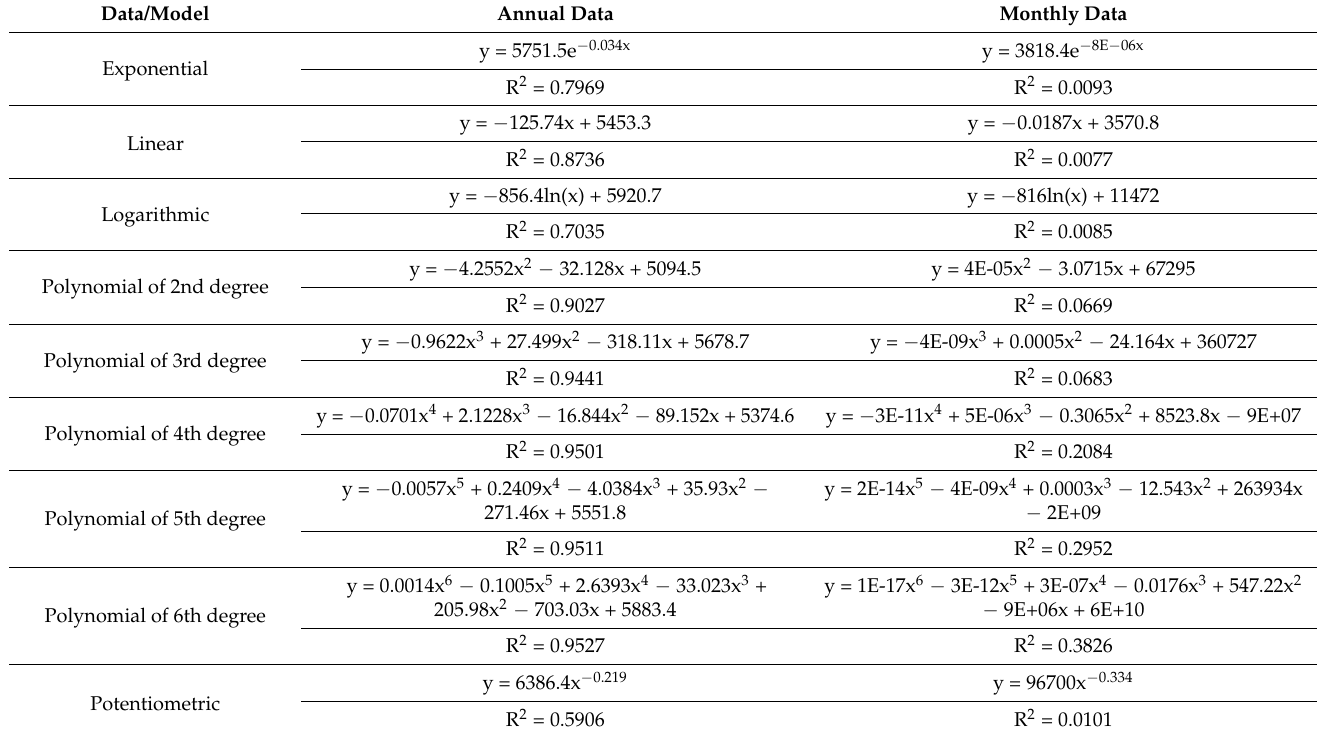
Table A6. Trend models for the Lesser Poland province.